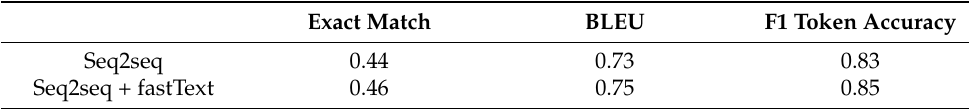
Table 5. Experiment results of the Seq2seq model. Exact Match BLEU F1 Token Accuracy